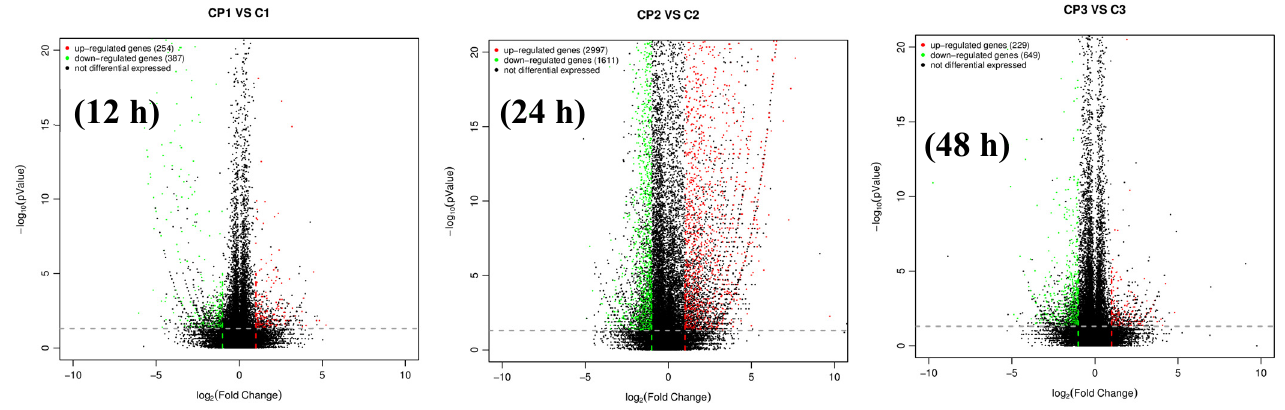
Figure 3. Living cell counts after transfection. ( A ) 24 h post transfection, ( B ) 48 h post transfection